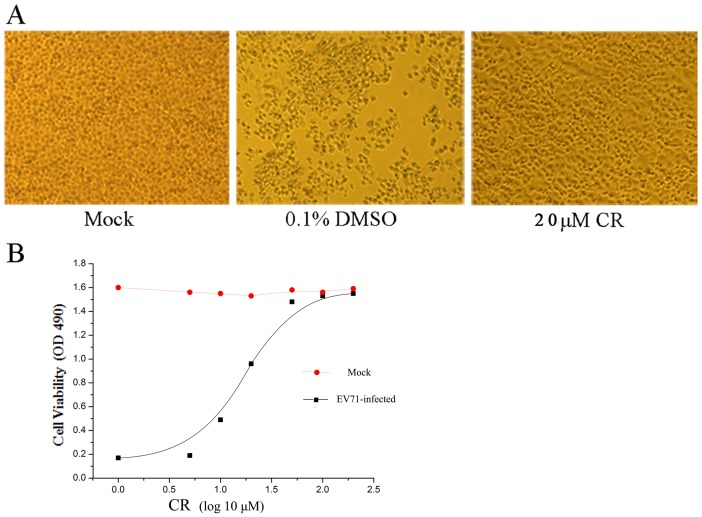
The effect of CR on EV71 infection.(A) CR reduced virus-induced cytopathic effects in RD cells. (B) CR protected RD cells from EV71 infection (P<0.05). The experiment was performed in triplicate; bars represent means ± SD.